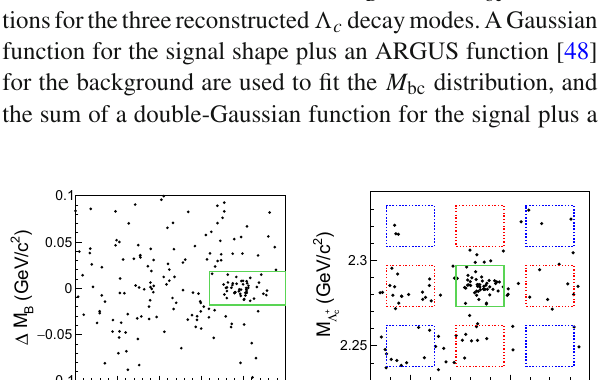
mass sidebands as half of the total number of events in c the four sideband regions next to the signal region minus one quarter of the total number of events in the four sideband